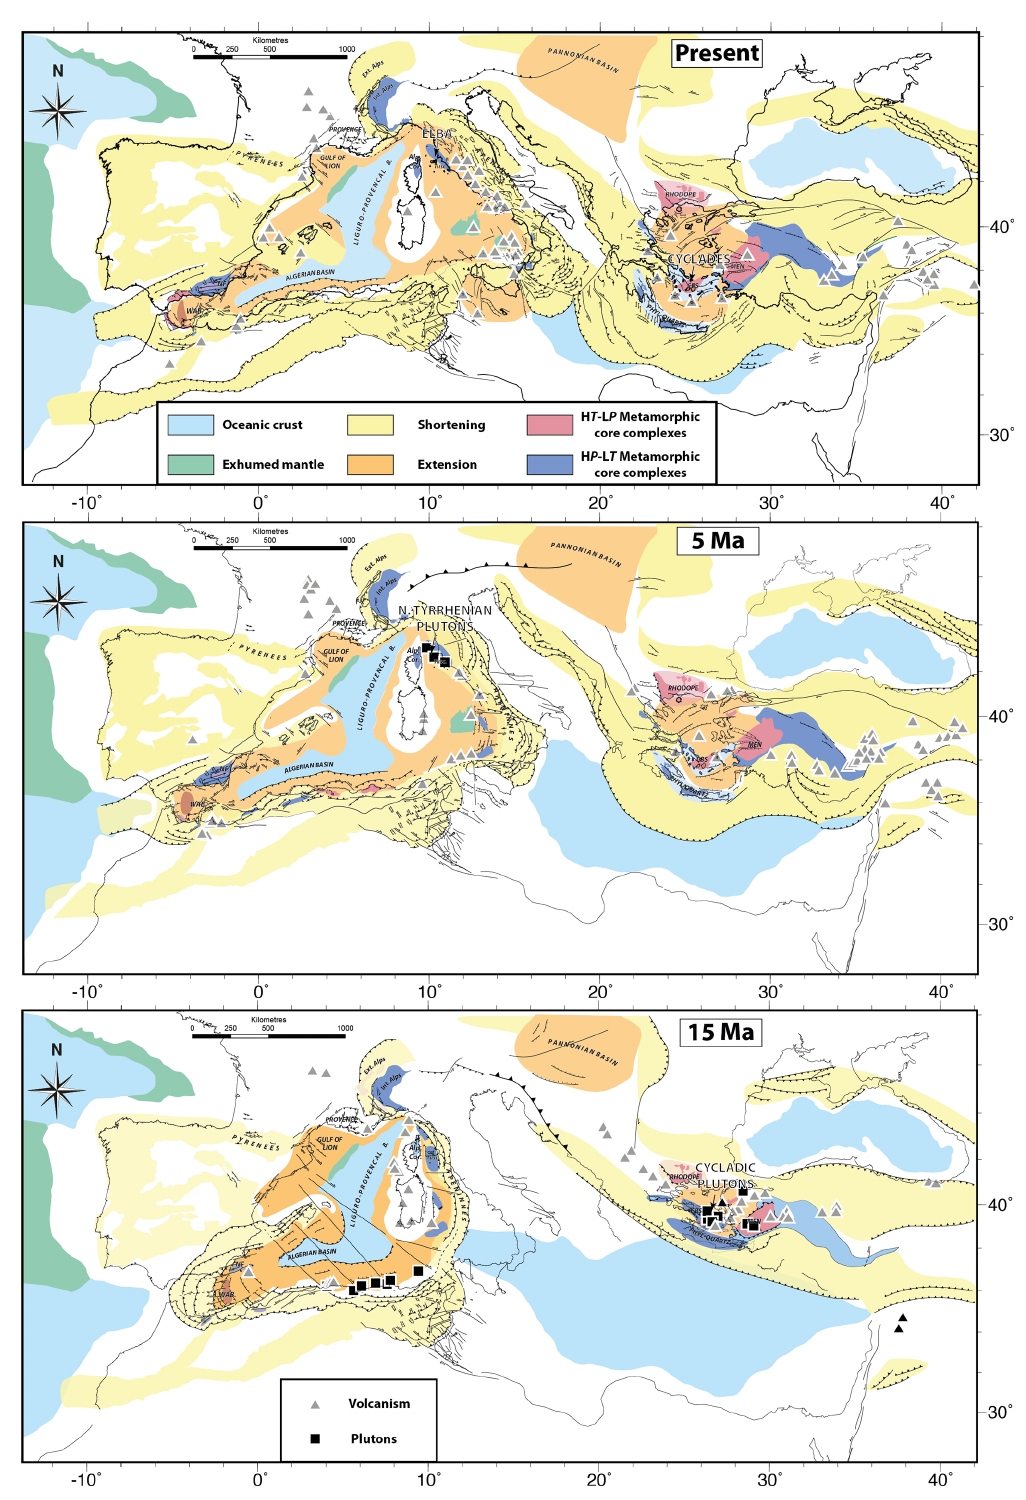
Figure 1. Present-day tectonic context of the Mediterranean region and two reconstructions at 5 and 15Ma showing the position of volcanic edifices and plutons with an emphasis on the cases of the Cyclades and the island of Elba addressed in this paper. These reconstructions are taken and modified from Romagny et al.